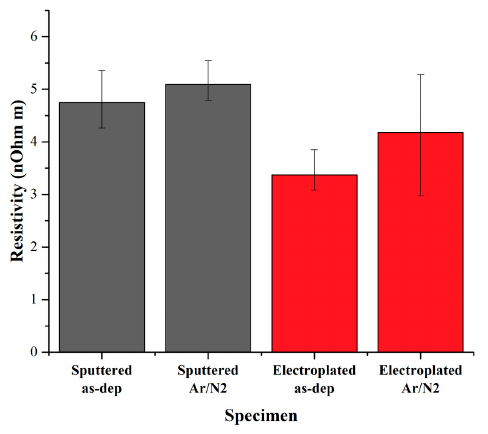
Figure 7. Estimated resistivity of plasma treated Cu thin films by measuring sheet resistance.